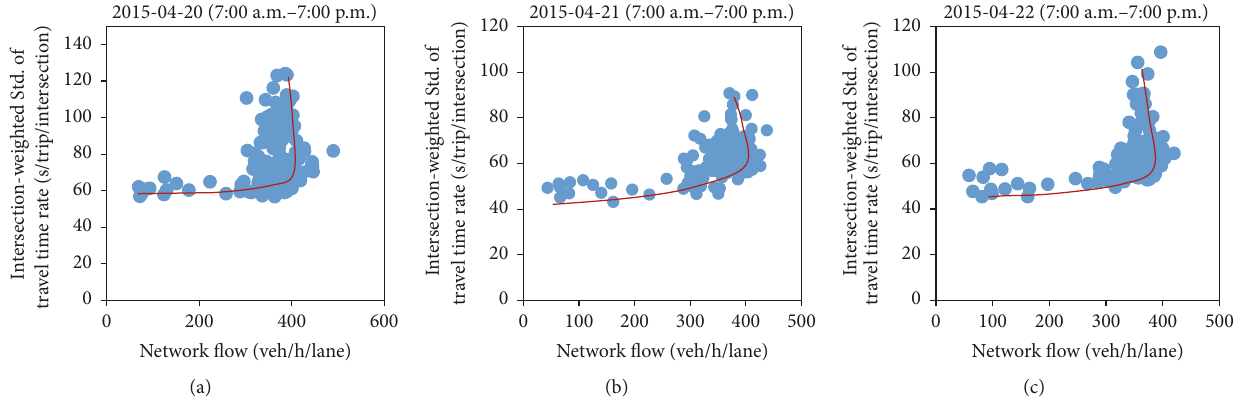
Figure 10: Intersection-weighted standard deviation of travel time rate versus network